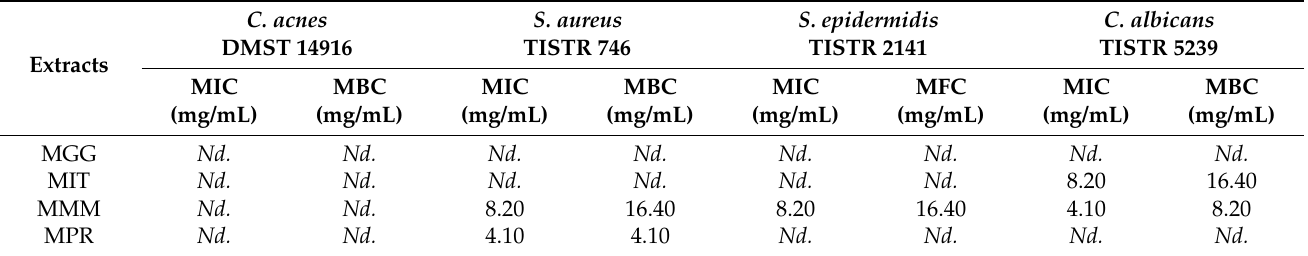
Table 3. Antimicrobial activities of four Mucuna seed extracts evaluated by the broth microdilution